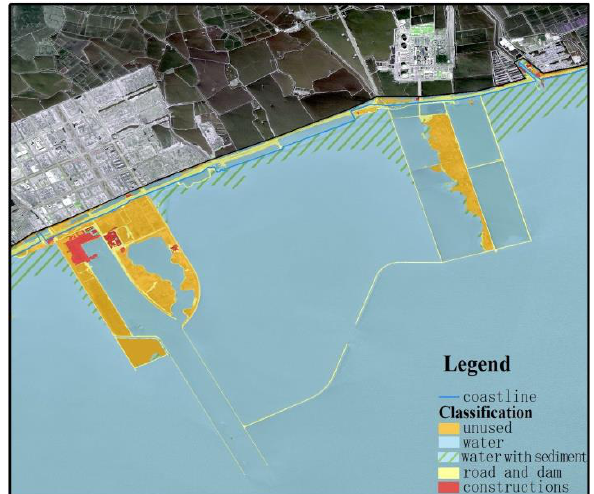
Figure 3. The classification result in the coastal